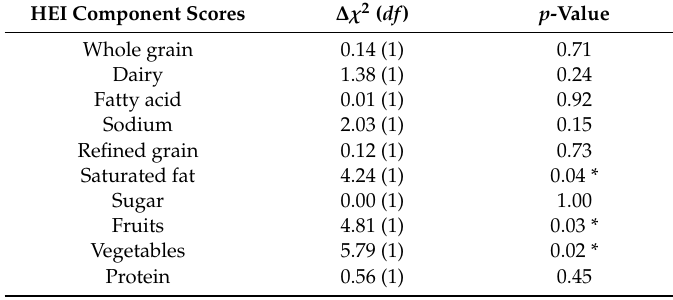
Table 5. Model comparison between the freely estimated and individually constrained pathway models for step 4 of the depression and specific diet indices